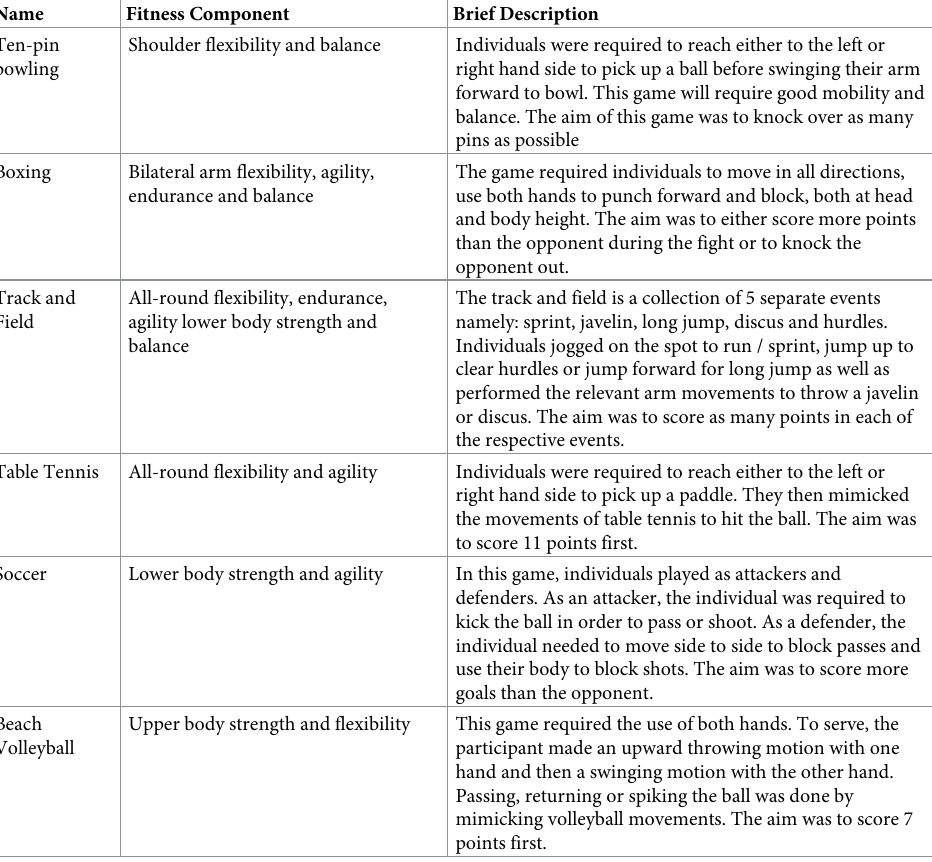
Table 2. Description of interactive video